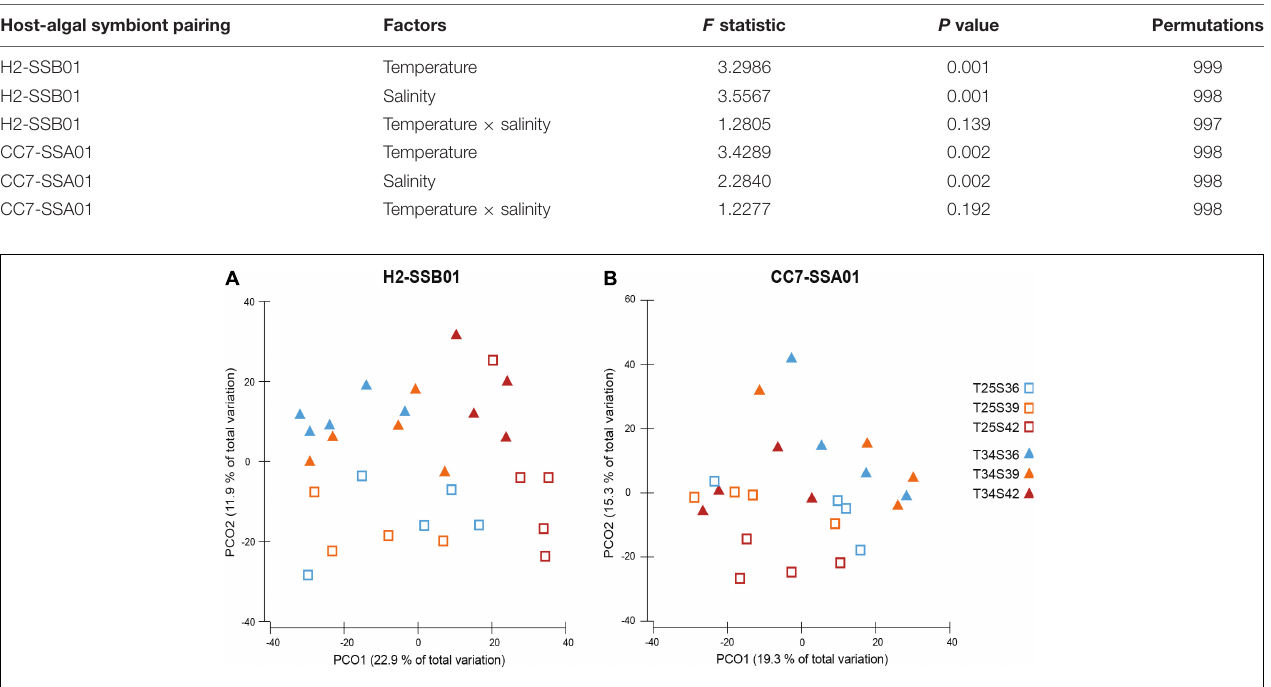
FIGURE 2 | Principal coordinate analysis (PCoA) of Aiptasia host-algal symbiont pairings (A) H2-SSB01 and (B) CC7-SSA01 across temperatures and salinities based on Bray–Curtis dissimilarity of bacterial OTU abundances. Blue = low salinity (36 PSU), orange = intermediate salinity (39 PSU), red = high salinity (42 PSU), open squares = ambient temperature (25 ◦ C), and closed triangles = heat stress (34 ◦ C). Variation explained by the two coordinates are denoted by percentages on the